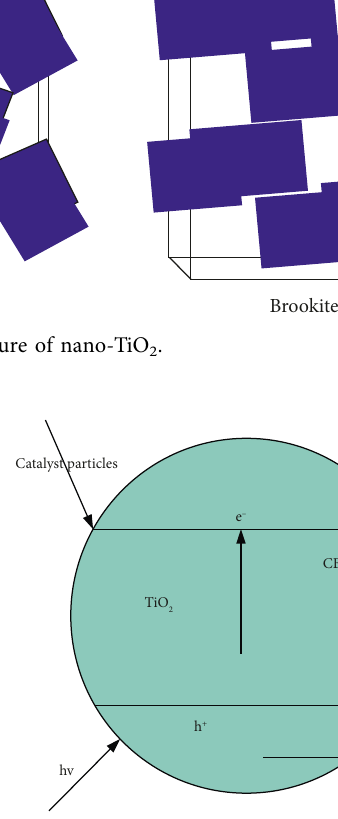
Figure 2: Schematic diagram of the photocatalytic mechanism of TiO